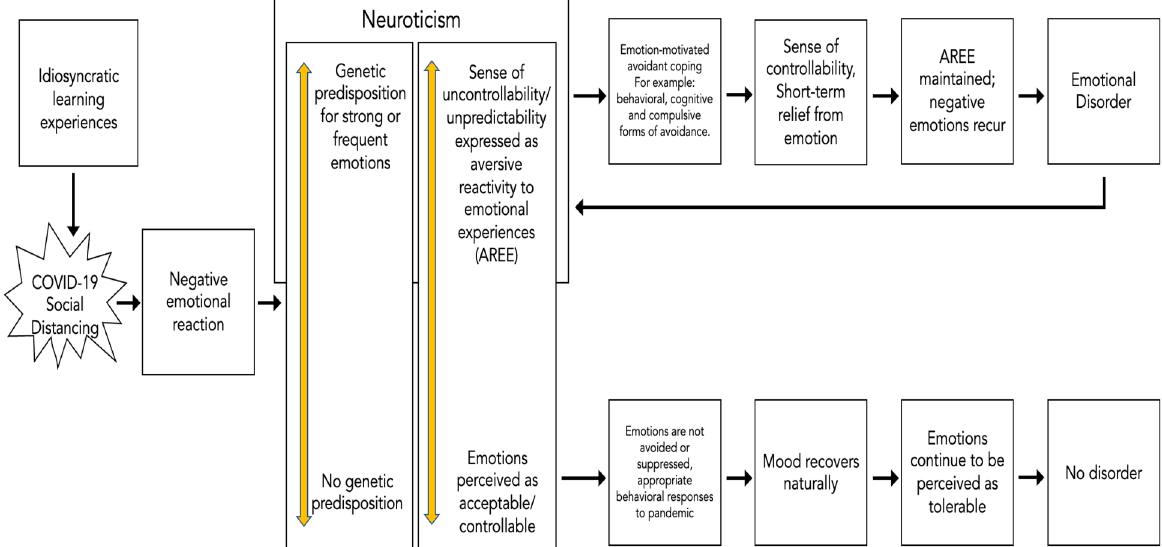
Figure 1. Model of the mechanisms explaining the development of emotional disorders versus adaptive emotional responses (adapted from [16]). COVID-19 social distancing triggers emotional reactions universally. The top pathway indicates that people who have a more neurotic temperament, and who may have developed a sensitivity to social-distancing-related triggers due to idiosyncratic learning experiences, engage in avoidant coping (e.g., rumination, worry, experiential avoidance), leading to the development and maintenance of emotional disorders. The bottom pathway describes an adaptive response to social distancing associated with low neuroticism and non-avoidant coping, leading to no disorder.